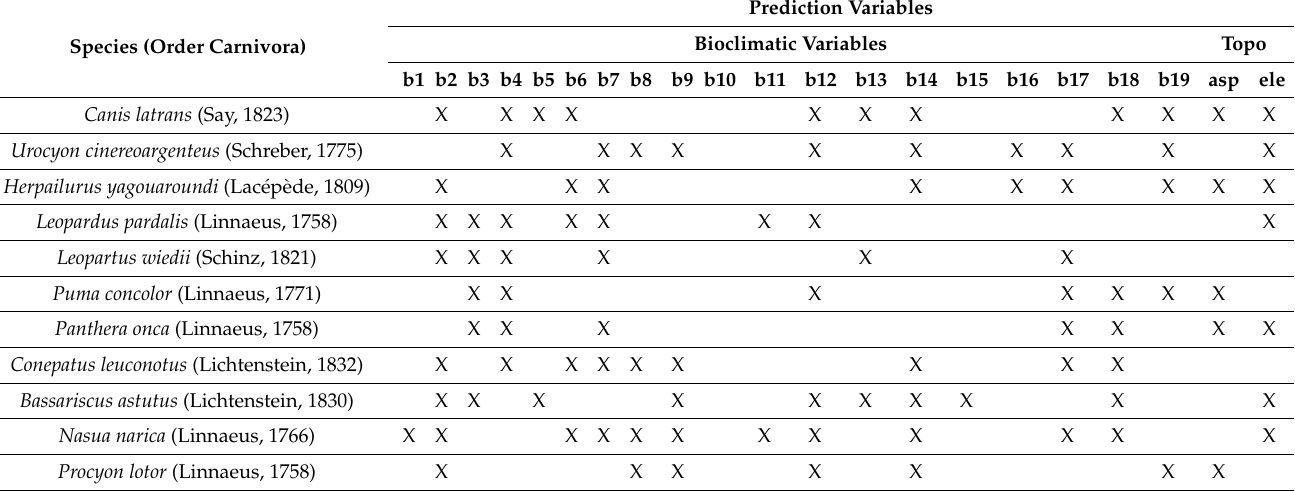
Table 2. Variables used in the elaboration of bioclimatic envelope models for carnivore species in western M é xico. Selected variables per species represented ≥ 95% in prediction importance. A complete set of variables was used to select the important prediction variables for each